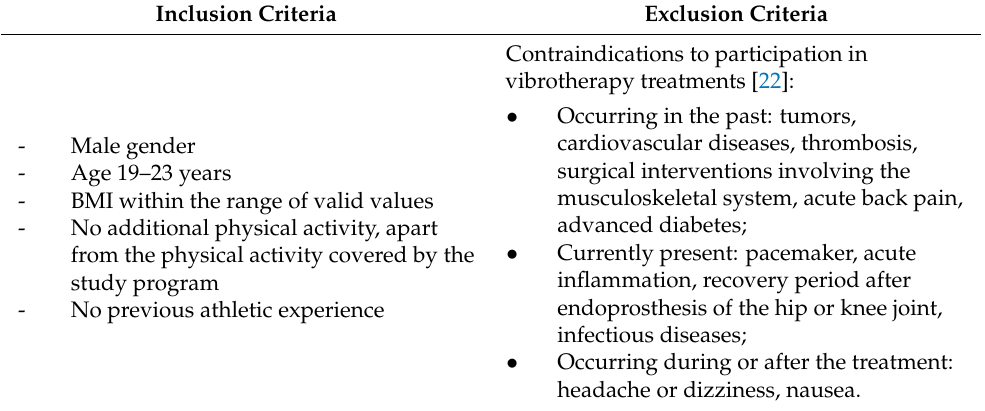
Table 1. Inclusion and exclusion